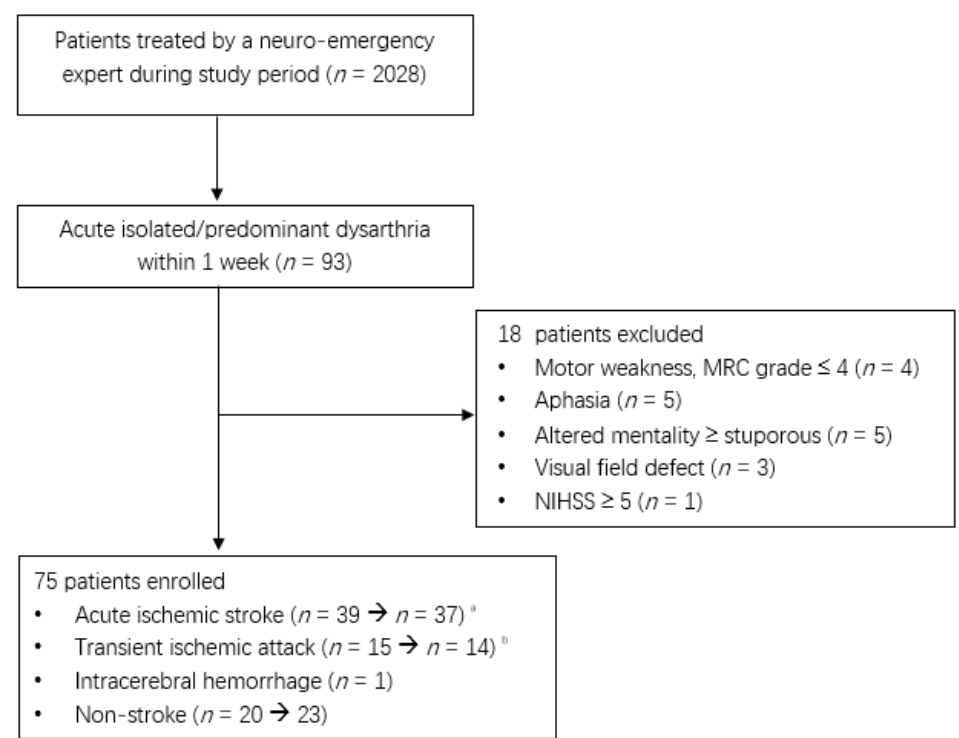
Figure 1. Flow diagram of enrolled patients during the study period (1 January 2020 to 31 December 2021). a . Two patients were diagnosed with multiple sclerosis and multiple cranial neuropathies. b . One patient’s diagnosis was changed to focal seizures.